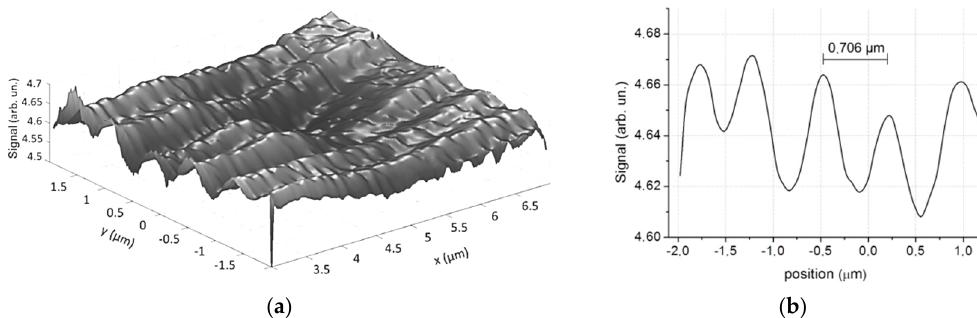
Figure 3. ( a ) Image of the near field of LED patterned with 1D PhC structure and ( b ) corresponding NSOM line profile across the structure.